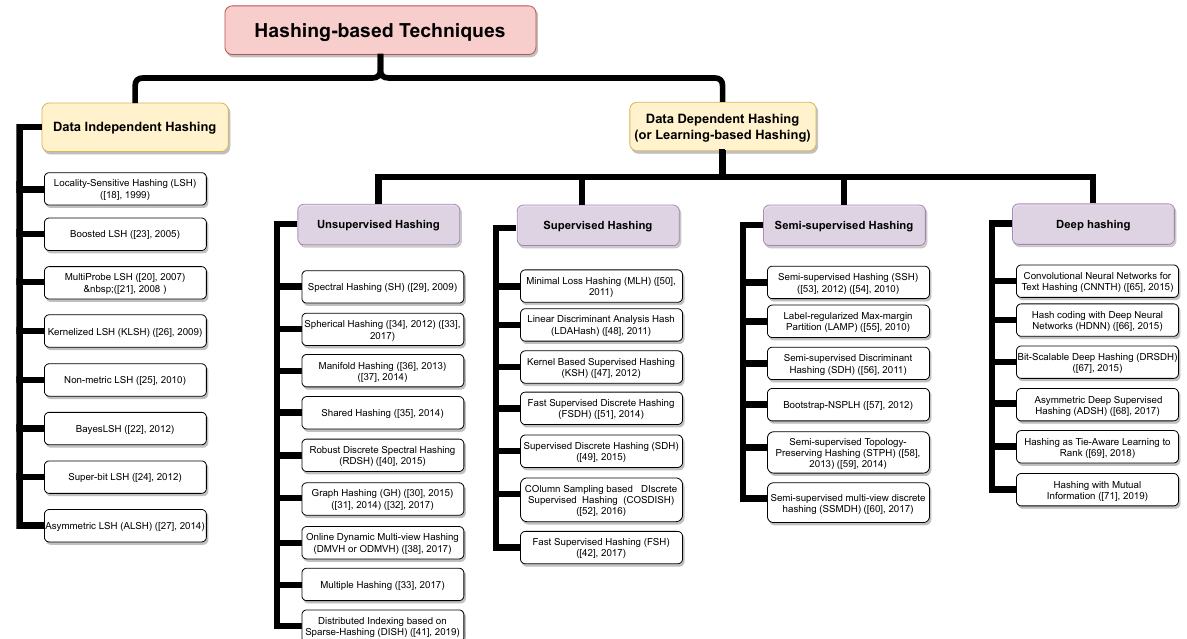
Figure 7. Taxonomy of hashing-based indexing